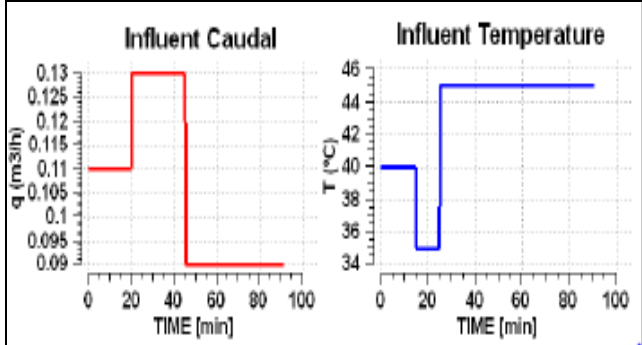
Figure 3: Diagram of the disturbances in the influent.